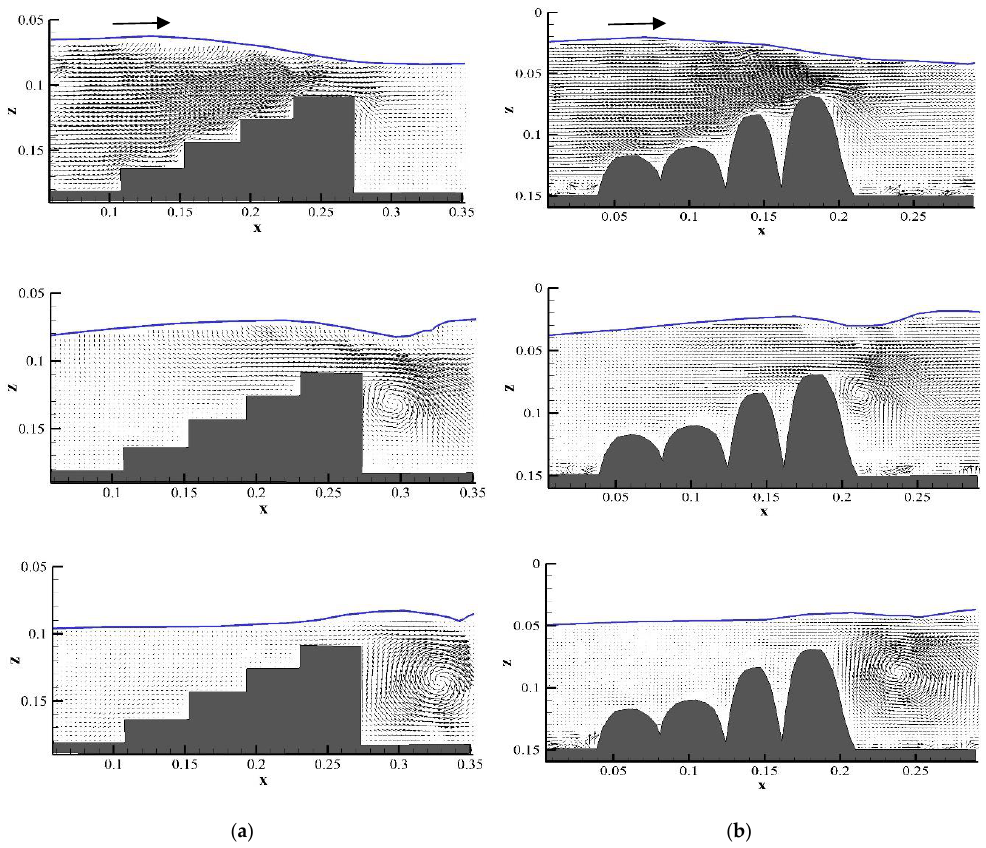
Figure 7. The vortex and velocity distribution around a single set of submerged breakwaters: ( a ) rectangular submerged breakwater; ( b ) undulating submerged breakwater.